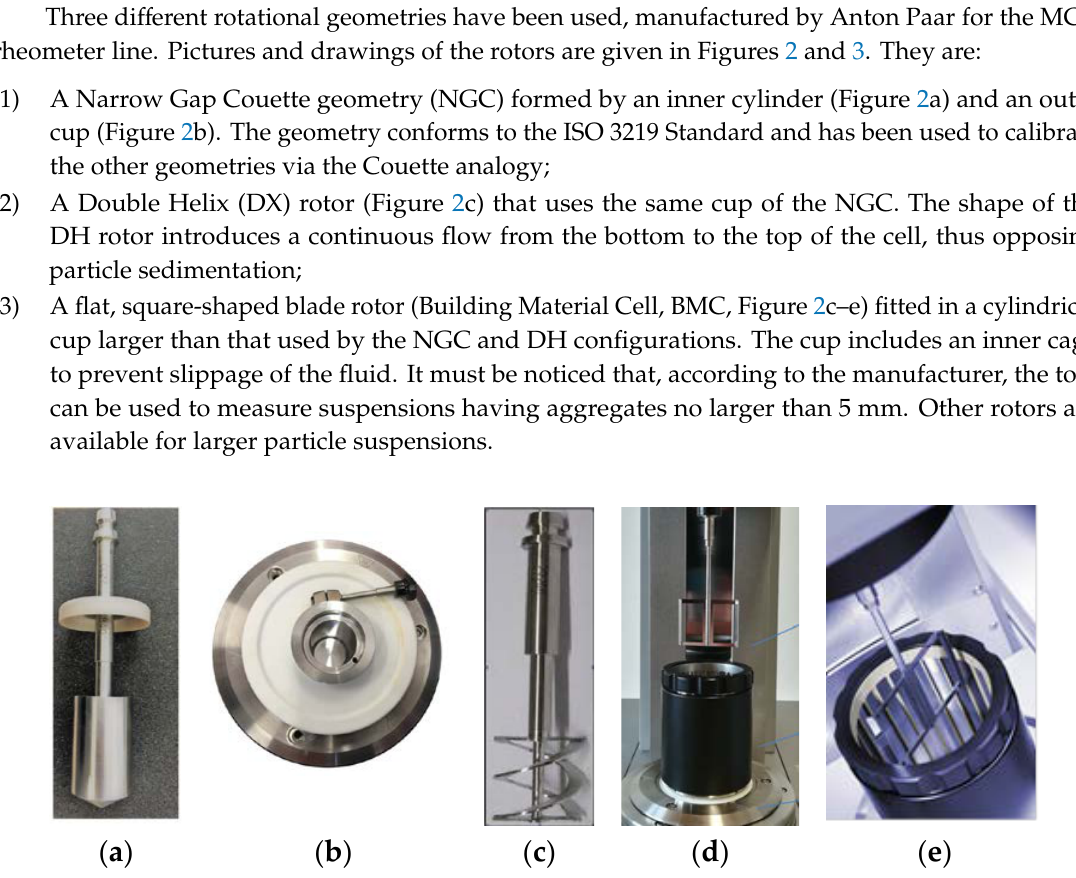
Figure 2. The rotors used in this work: ( a ) Narrow Gap Couette (ISO 3219); ( b ) Top view of the cup used for both the Narrow Gap Couette (NGC) and the Double Helix geometry; ( c ) Double Helix (DH); ( d ) Building Material Cell (BMC); ( e ) A close-up of the BMC cup.